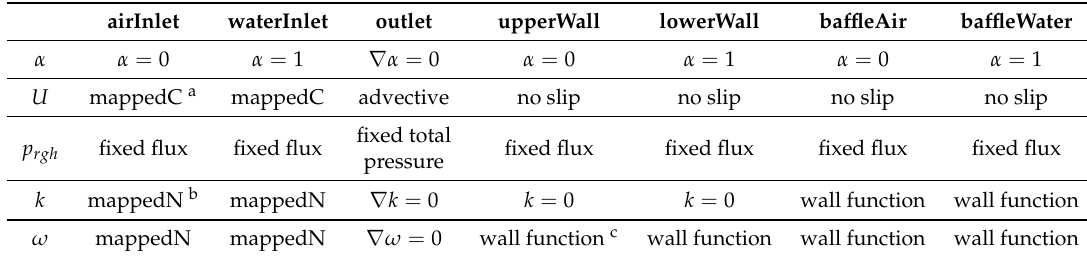
Table 2. Boundary